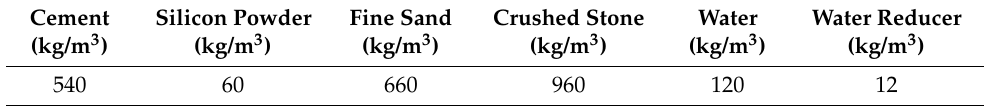
Table 4. Basic ratio of concrete.